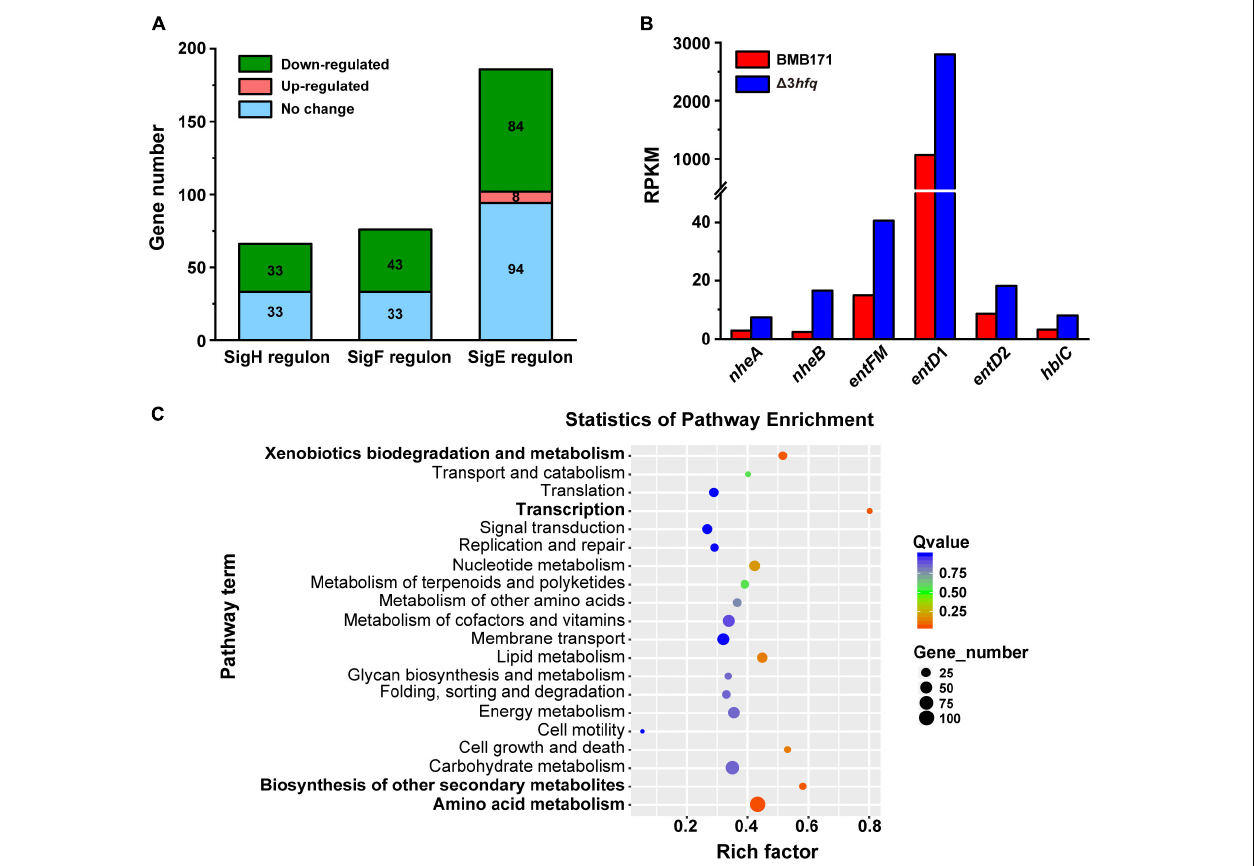
FIGURE 6 | Transcriptome statistics of genes associated with sporulation affected by Hfq deletion. (A) Statistics of differential expression of downstream genes regulated by the sigma factors SigH, SigF, and SigE that control sporulation by BMB171 and (cid:49) 3 hfq . (B) Difference in gene expression of related virulence factors in BMB171 and (cid:49) 3 hfq . (C) Enrichment map of KEGG pathway of BMB171 and (cid:49) 3 hfq DEGs. The names of the four significantly enriched pathways are shown in